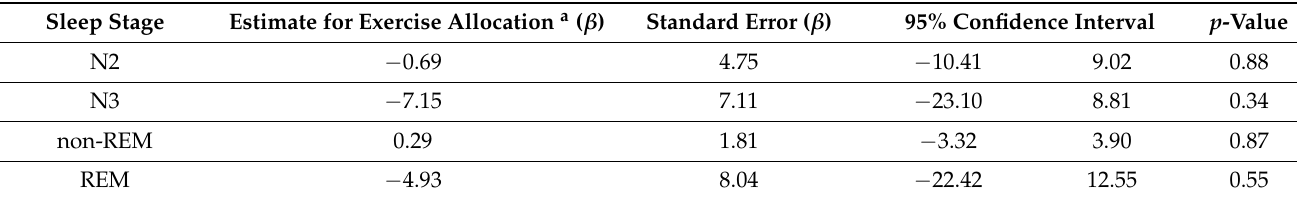
Table 4. Coefficients of exercise allocation in intent-to-treat ANCOVA models predicting RMSSD outcomes during different sleep stages.